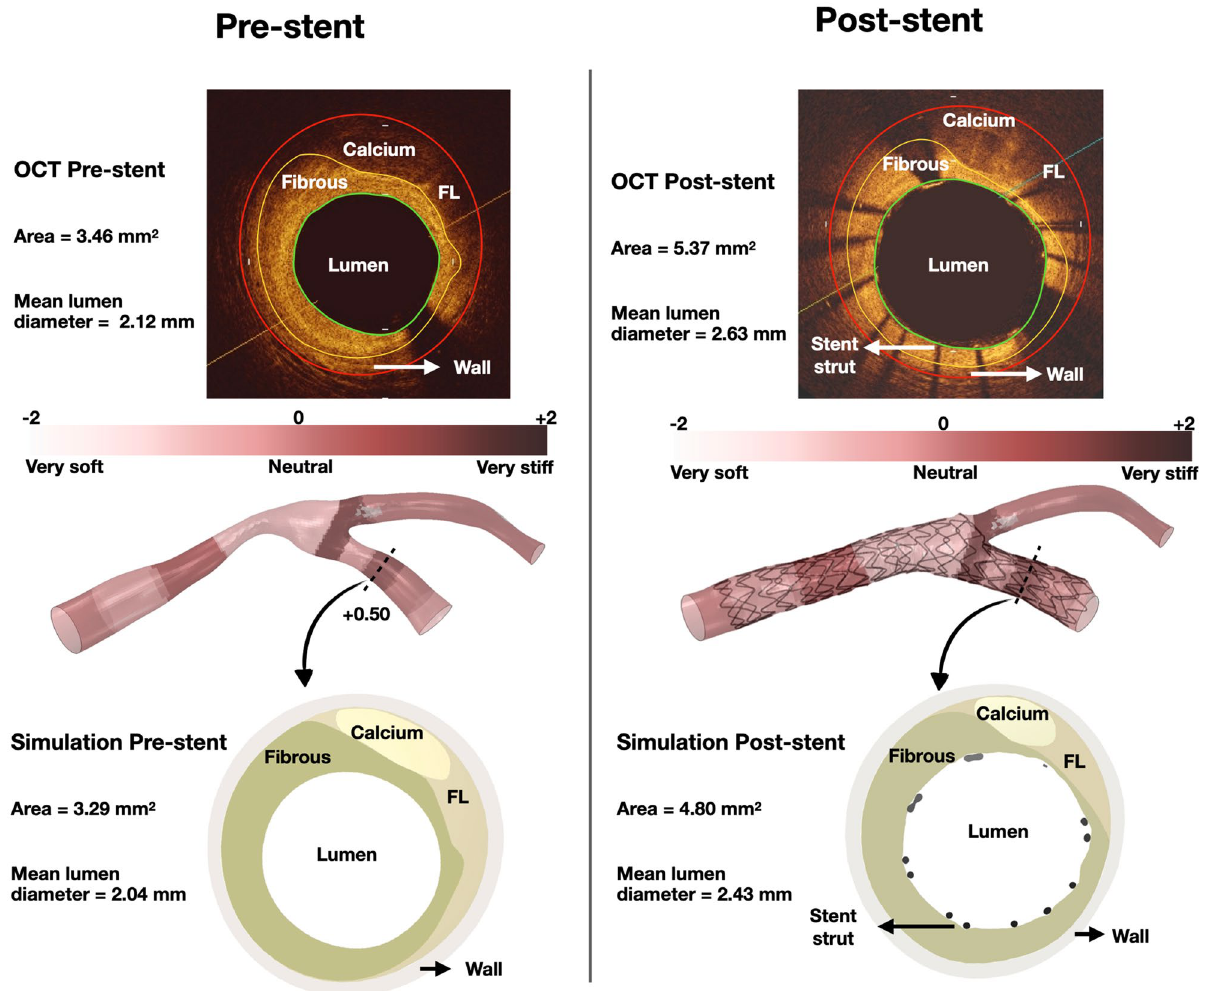
Figure 8. Representative example showing the similarity between computational stenting simulation and reality (OCT). Left column shows the lumen size pre-stenting and right column shows the lumen size post-stenting. The figure illustrates the pre-procedural 3D reconstructed vessel anatomy and plaque stiffness, as well as the post-procedural stented vessel. Note the similarity in pre-stenting lumen size, shape and plaque constituents by OCT versus computational simulation. In the computational simulation, this vessel cross-section was assigned + 0.50 plaque stiffness based on OCT imaging. Likewise, note the similarity in post-stenting lumen size and shape, as well as stent size and circumferential configuration by OCT and computational simulation; FL fibrolipid.